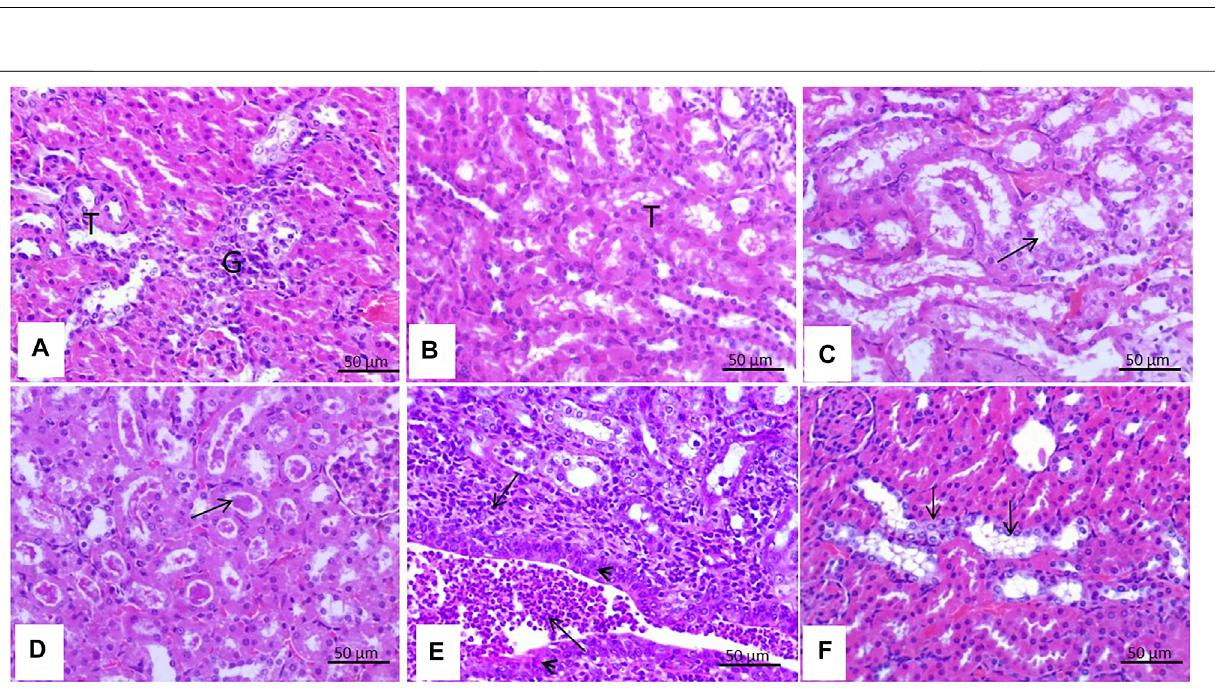
Frontiers in Environmental Science |